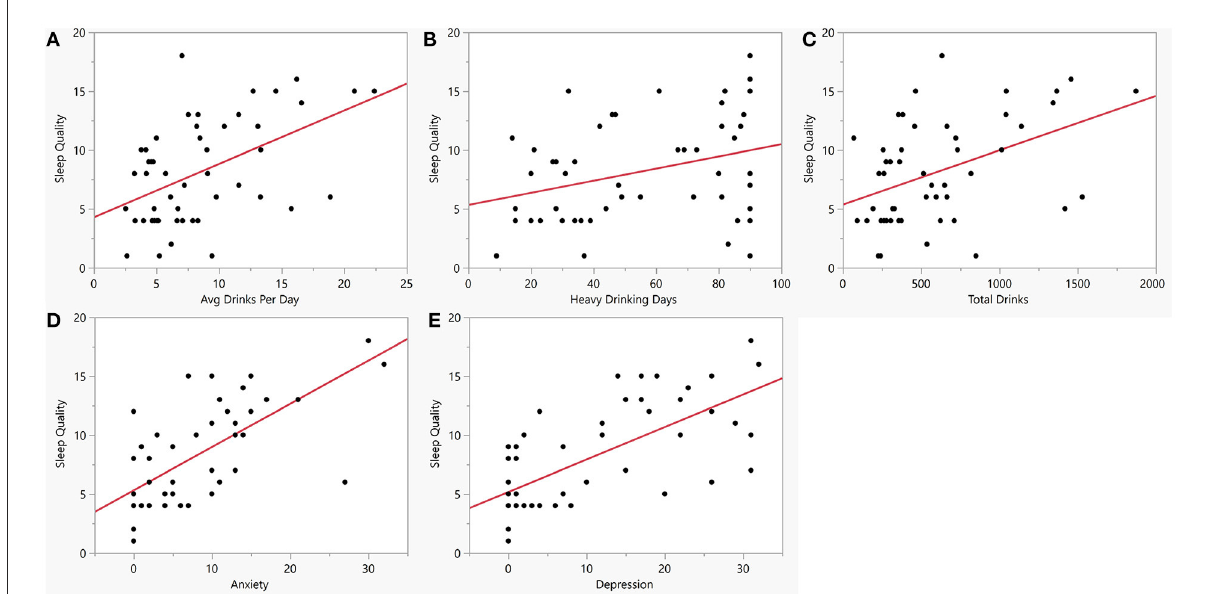
FIGURE3 Bivariate plots between sleep quality, alcohol consumption, anxiety and depression within the AUD group. Y-axis is sleep quality (PSQI score) vs. (A) Average drinks per day (x-axis, AUD: R = 0.50, p < 0.001). (B) Number of heavy drinking days (x-axis, AUD: R = 0. 32, p = 0.02). (C) Total drinks (x-axis, AUD: R = 0.44, p = 0.001). (D) Anxiety measured by BSA (x-axis, AUD: R = 0.66, p < 0.001). (E) Depression measured by MADRS (x-axis, AUD: R = 0.67, P < 0.001). Red line represents regression line.